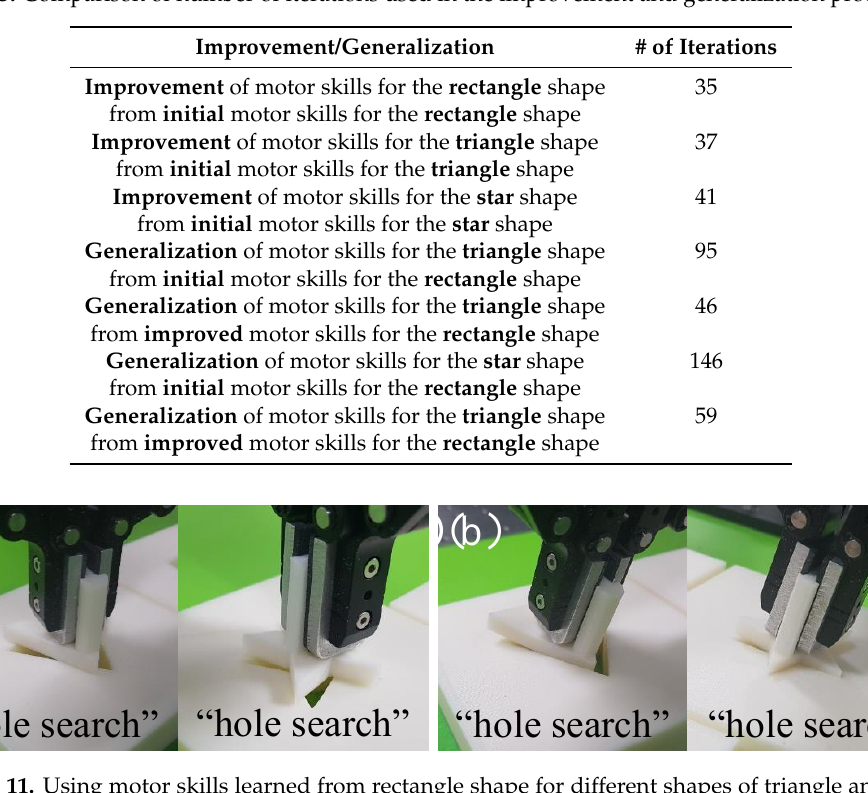
Figure 11. Using motor skills learned from rectangle shape for different shapes of triangle and star: ( a ) failure cases; and ( b ) the successful completion of the cases in ( a